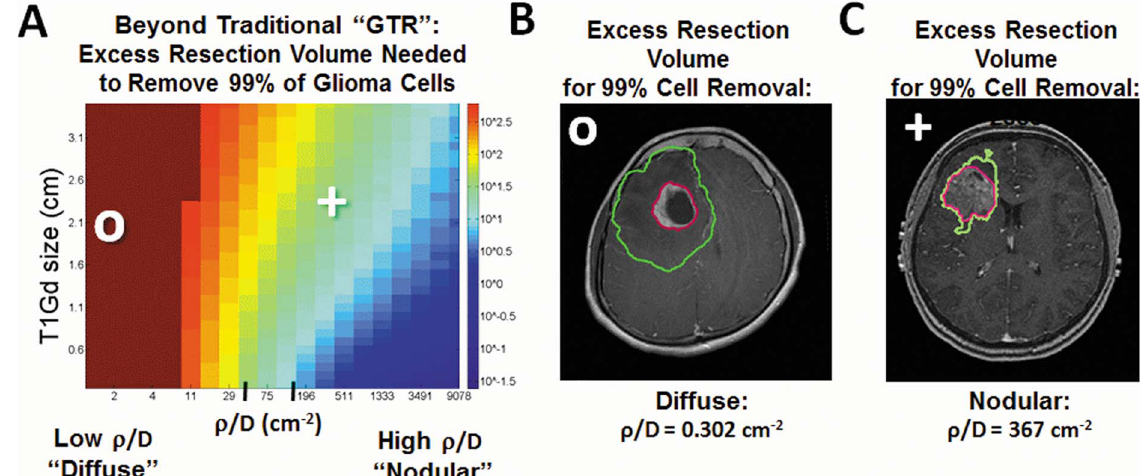
Figure 3. Extent of resection necessary to attain significant reduction in glioma cell burden. A) Simulated predictions of the additional resection volume beyond GTR of the T1Gd abnormality needed to achieve 99% reduction in tumor cell burden, a 2 log kill of tumor cells. The color scale maps to the additional volume (ranging from 10 2 1.5 to 10 2.8 , corresponding to hemispherectomy of an approximately 1200 cm 3 brain volume) outside of the T1Gd abnormality needed to attain desired tumor cell removal. The cutoffs between low and moderate r /D (37.2 cm 2 2 ) and moderate and high r /D (135 cm 2 2 ) are displayed as tick marks on the horizontal axis. These theoretical resection margins necessary to achieve a 2 log kill of tumor cells are visualized for b) a diffuse tumor which requires an extra 237 cc of tissue (green contour) to be removed beyond a conventional GTR of the T1Gd abnormality (pink contour). In contrast, only 25 cc of brain tissue needs to be resected to remove 99% of the glioma cells in the more nodular glioma (c).